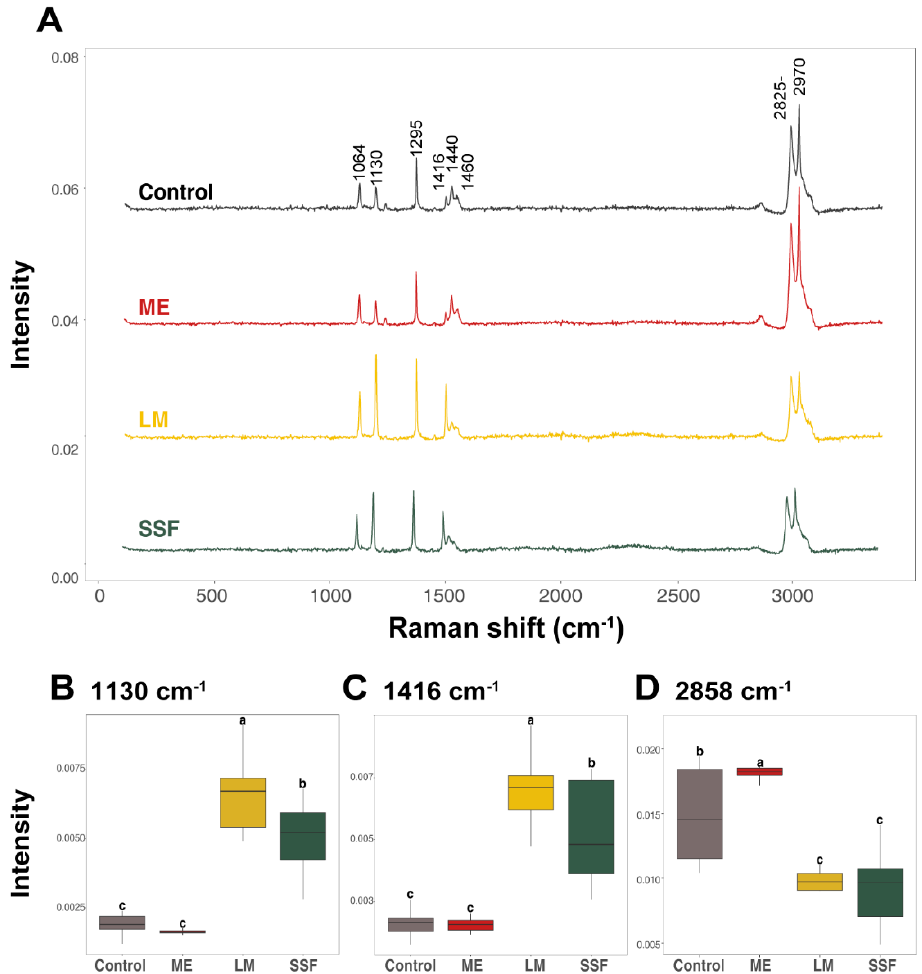
Figure 3. Discrimination of the control and treated HDPE after 90 days of treatment with the fungal isolate TBB-03. ( A ) represents the Raman spectra of each condition. Raman spectra were collected from 10 di ff erent locations, and an averaged spectrum was used for the analysis. Relative intensity plots of peaks at ( B ) 1130 cm − 1 , ( C ) 1416 cm − 1 , and ( D ) 2858 cm − 1 . Significant di ff erences at p < 0.05 between peaks were calculated using Duncan’s multiple range